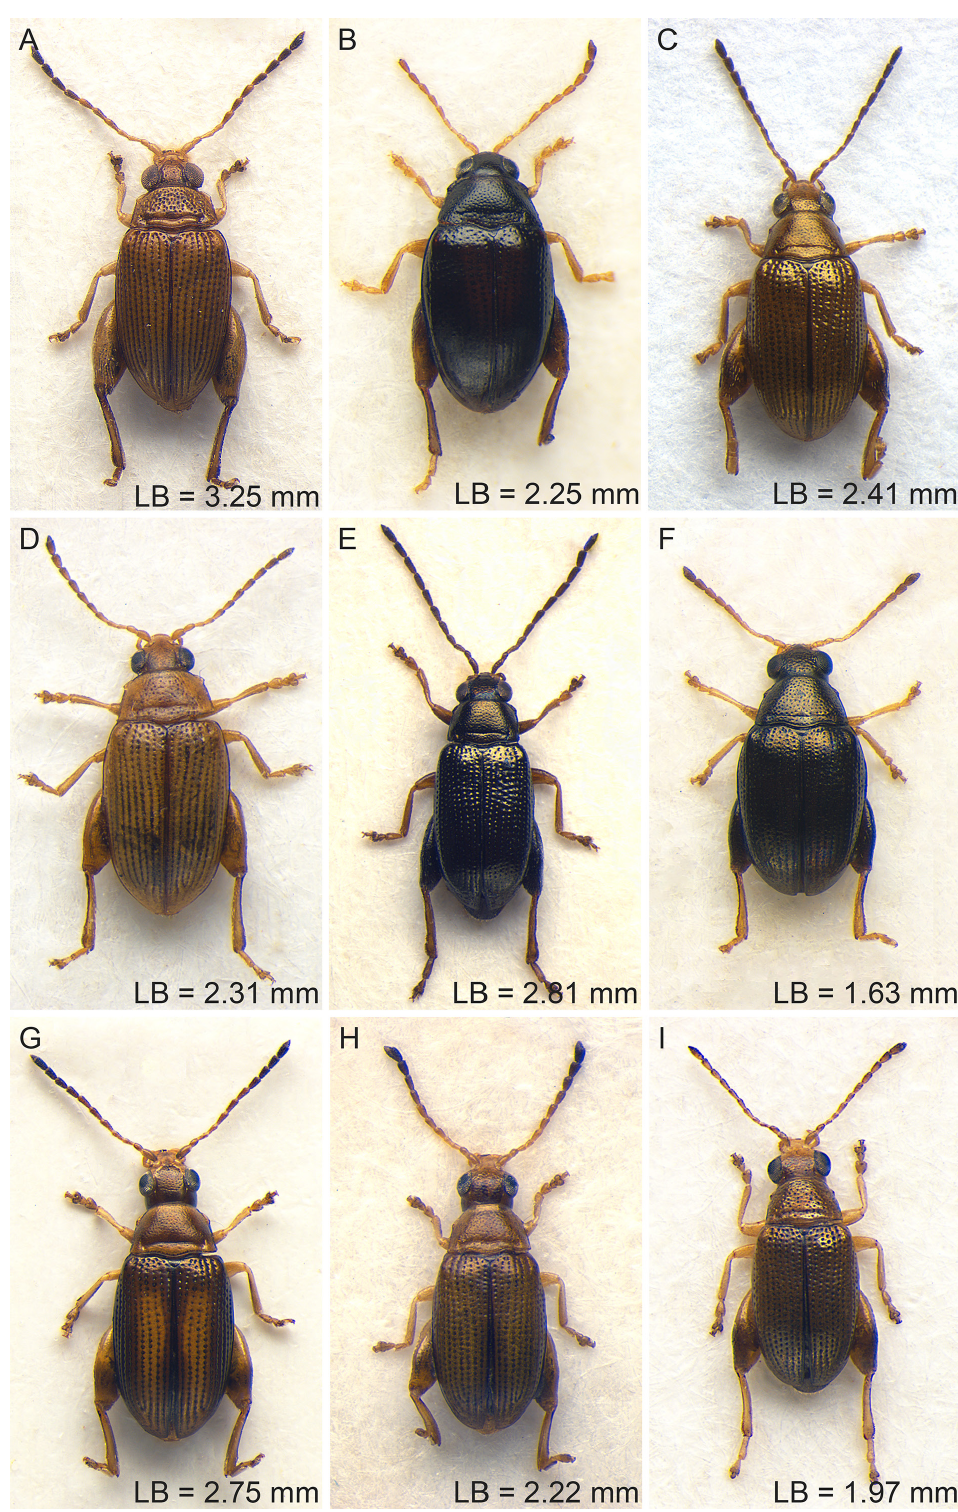
Fig. 1. Habitus. A . Arsipoda agalma Samuelson, 1973 , Mt Panié. B . A. atra sp. nov,